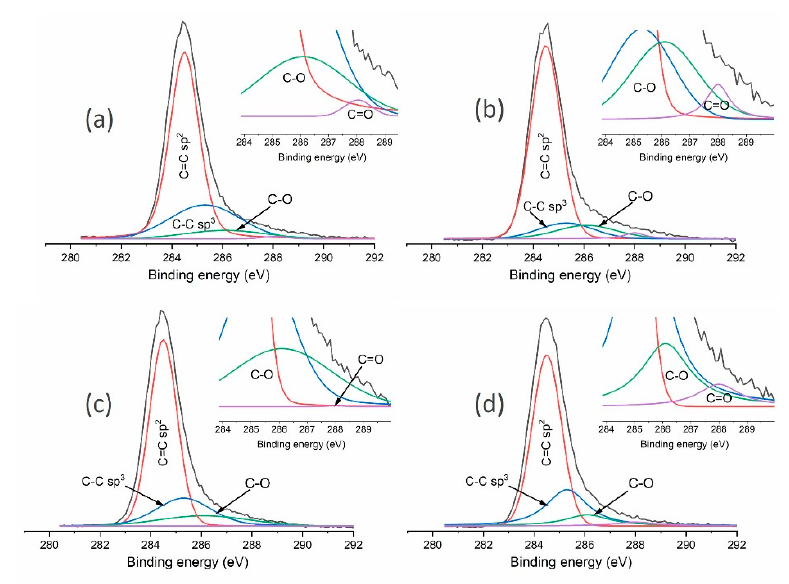
Figure 6. Analysis of C1s peaks obtained in XPS tests of powders produced using (a) the CVD method; (b) dry-milled; (c) milled in water; (d) milled in methanol.